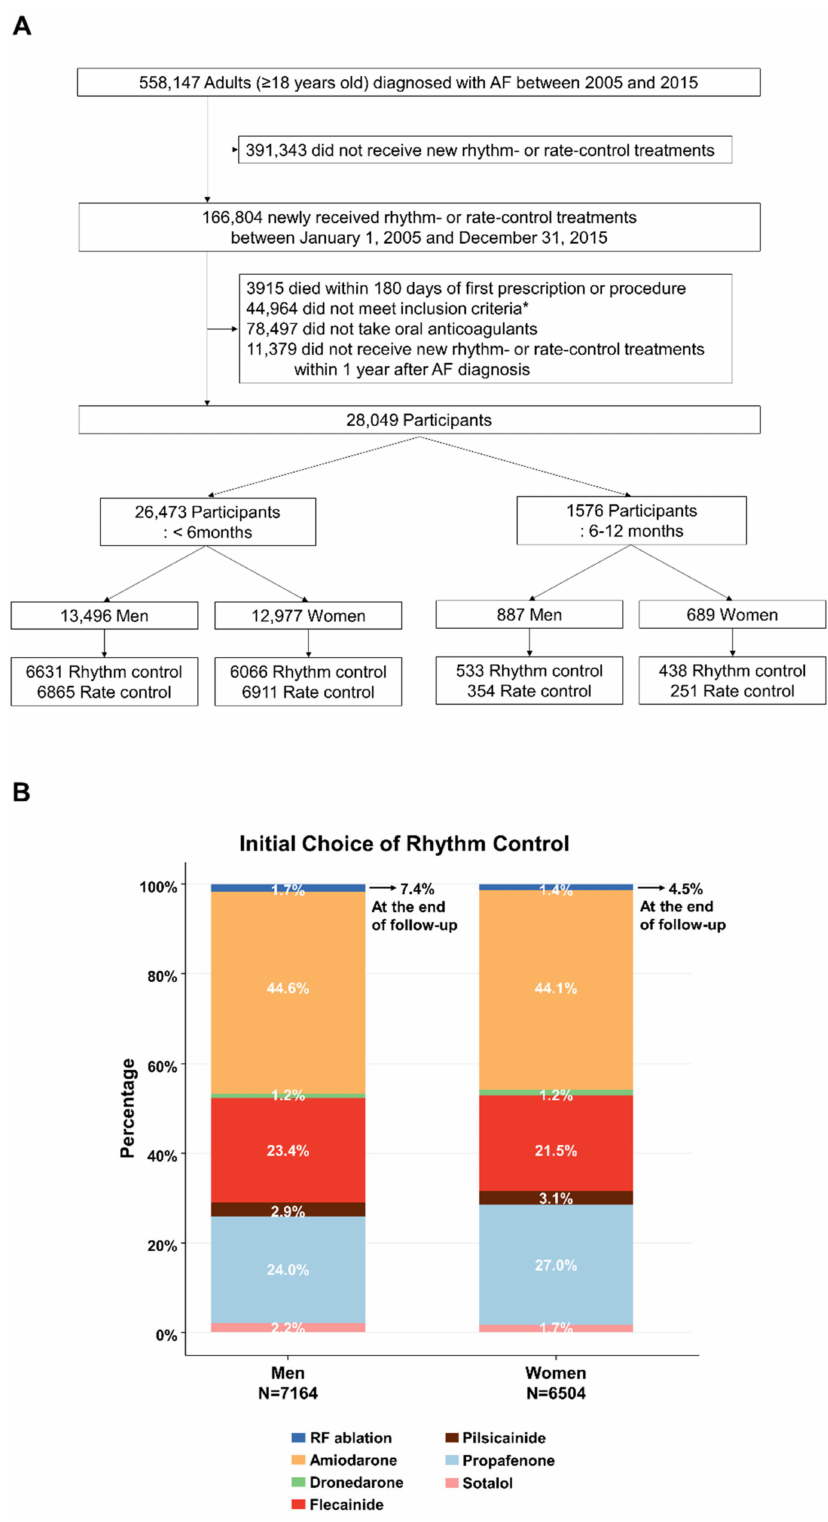
Figure 1. Flow chart. Selection of study participants ( A ) and initial rhythm control strategies according to sex and the timing of treatment initiation ( B ). * Age ≥ 75 years, previous transient ischemic attack or stroke, or two of the following criteria: age ≥ 65 years, women, hypertension, diabetes mellitus, heart failure, previous myocardial infarction, or chronic kidney disease. AF, atrial